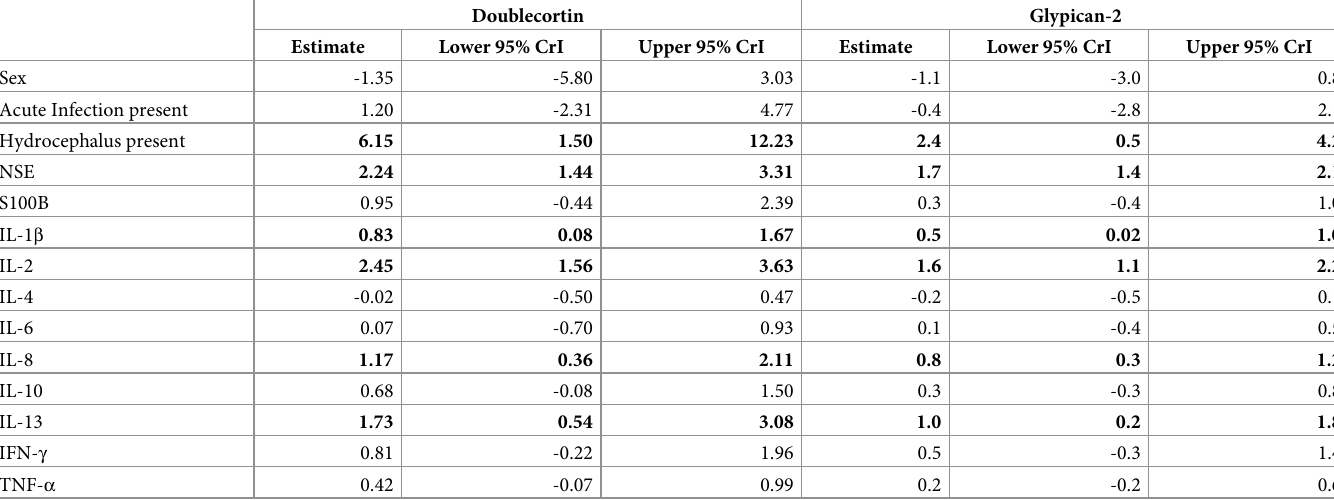
Table 3. Relationship between Doublecortin and Glypican-2 and important clinical parameters-overview of univariable linear regression